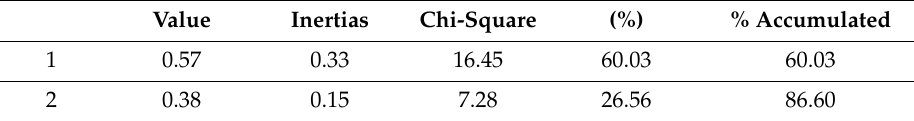
Table 8. Contribution to the Chi square of education and